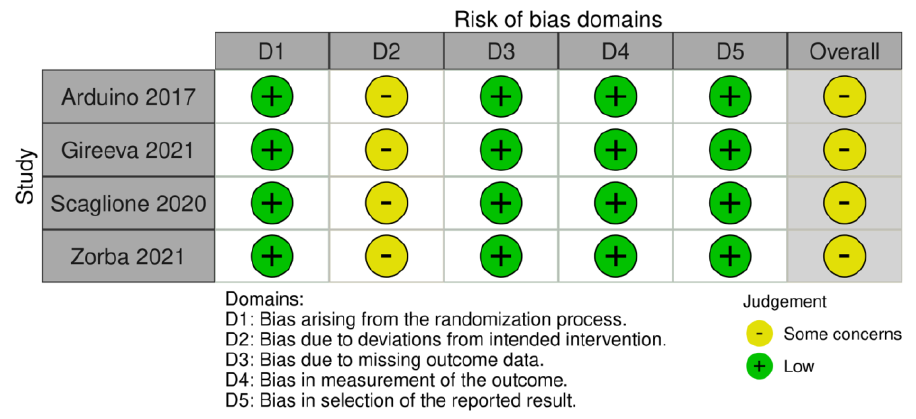
Figure 1. Summary of the risk of bias assessment. Table 1. Brief report of main data extracted from included papers. Mucous membrane pemphigoid (MMP); pemphigus vulgaris (PV); plaque-induced gingivitis (PG); polymerase chain reaction (PCR); next generation sequencing (NGS).